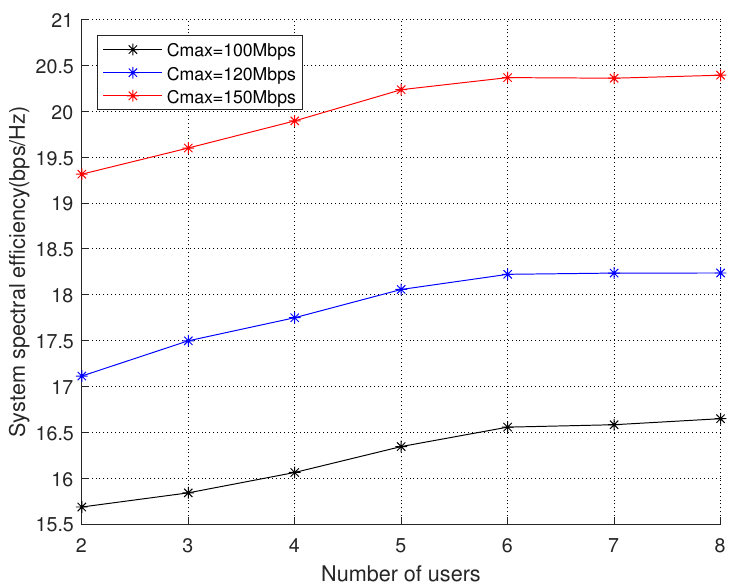
Figure 4. System SE versus the number of users for different C max limitations.